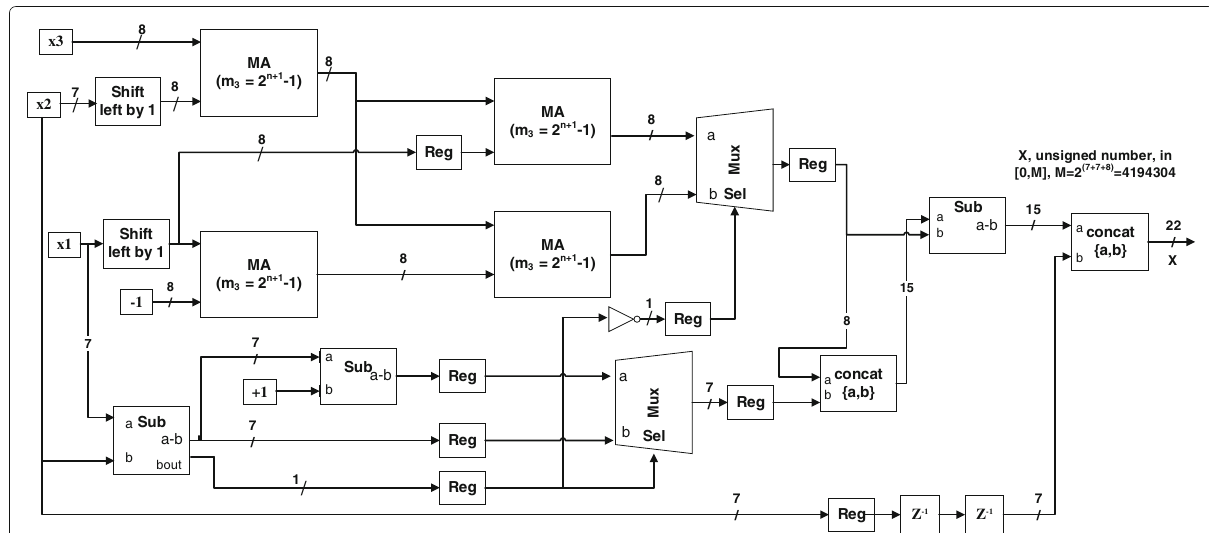
Fig. 6 The block diagram of the pipelined residue-to-binary converter for the three-channel RNS-based DWT, P 7 = { 127,128,255 } . Four identical 2 n + 1 − 1 MAs, three subtractors and two multiplexers are generally required for RBC. Two shift registers are used for extending the 7-bit input by one bit. In the real implementation this operation does not add any cost because this operation is just equivalent to appending 0 at the first location of the input signal